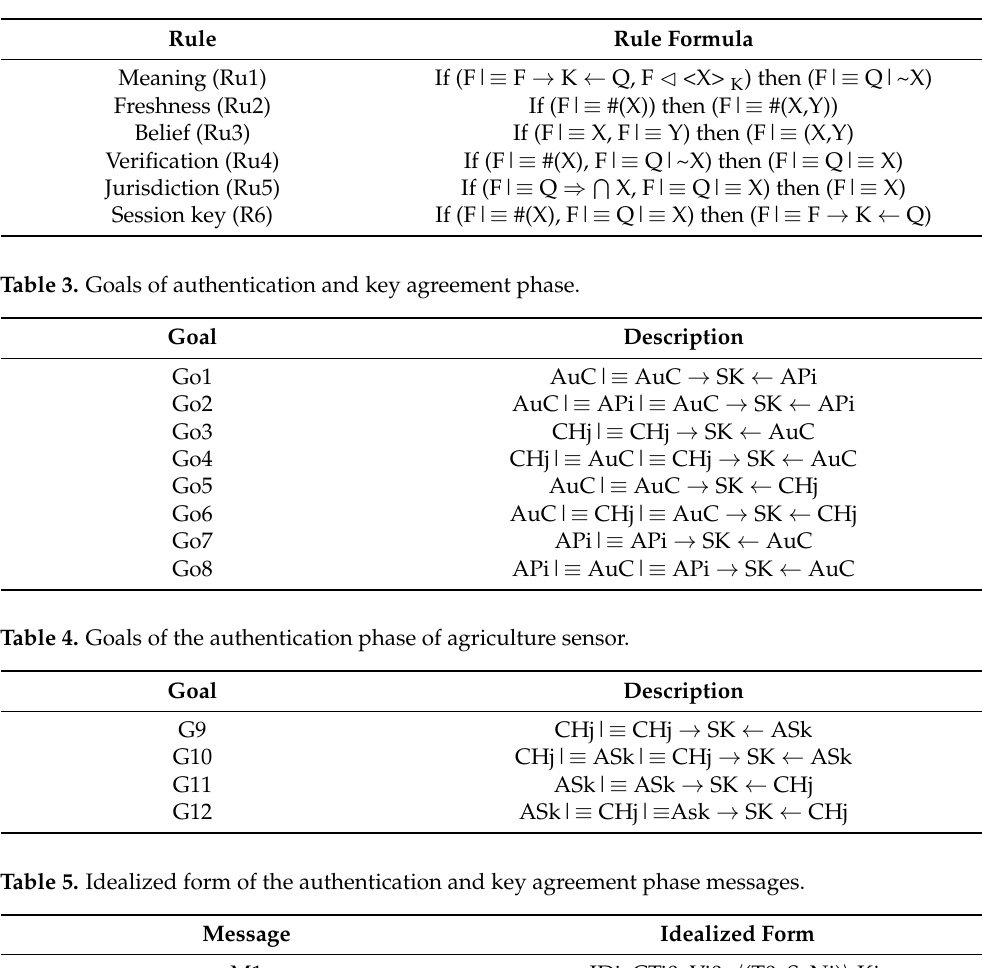
Table 2. Verification rules of ban logic model.